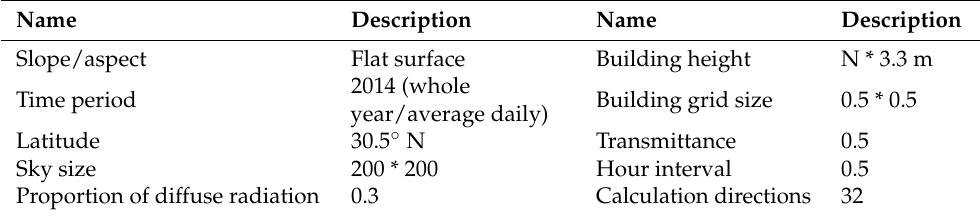
Table 1. Parameter settings for the solar simulation in ArcGIS Solar Analyst [20]. Name Description Name